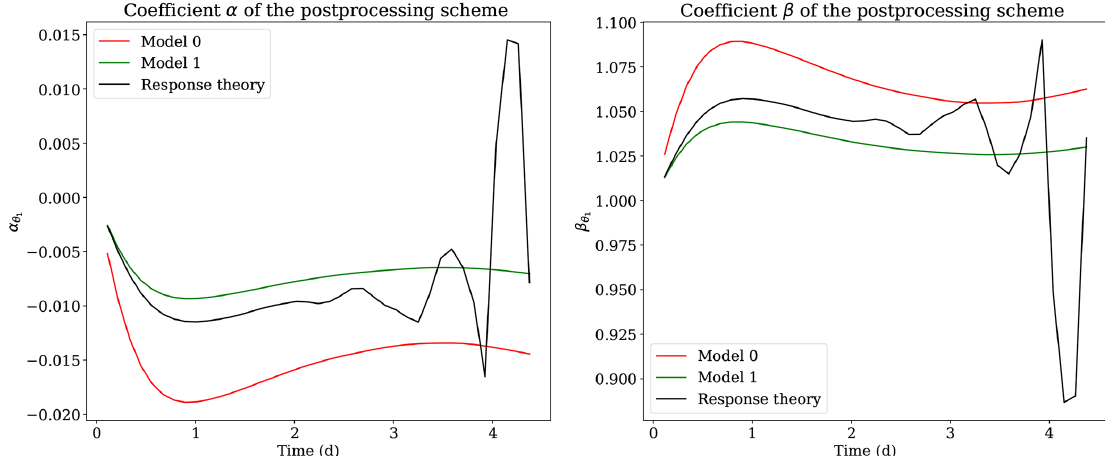
Figure 8. Coefficients α and β of the postprocessing schemes of variable θ 1 and their correction using the response theory, for the experiment with a modification of the Newtonian cooling coefficient.